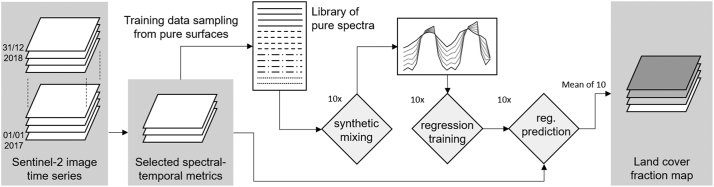
Basic workflow for KRR with synthetic mixing (workflow for one model). Libraries of pure spectra are drawn from image time series STM. Synthetic mixing uses those pure spectra to create artificial mixtures.